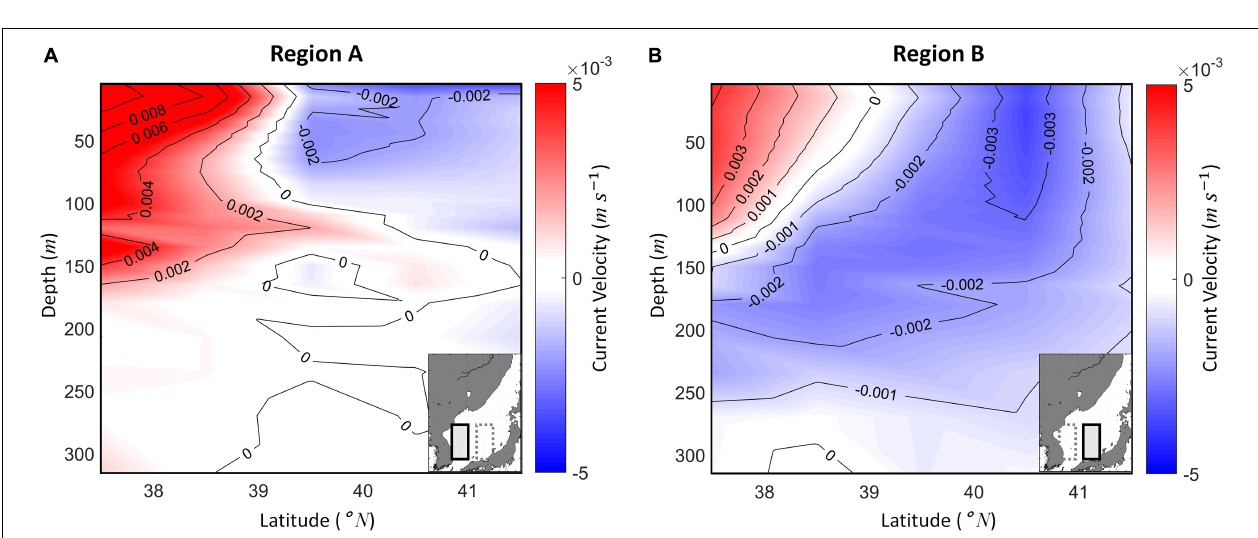
FIGURE 3 | Sectional structures across Regions A and B (shown in black dotted lines in small figures in the lower right corners) of trend differences between the SW and SWS periods (SWS–SW), of (A) subsurface temperature anomaly and (B) isopycnals between SW and SWS periods. The small figures within panels (A,B) are the same as those in Figures 2C,E , indicating the spatial pattern of the trend differences of subsurface temperature and isopycnals, respectively. Each arrow indicates the seawater or volume transport. Arrows pointing upwards mean upwelling and arrows pointing downwards mean downwelling processes, respectively.